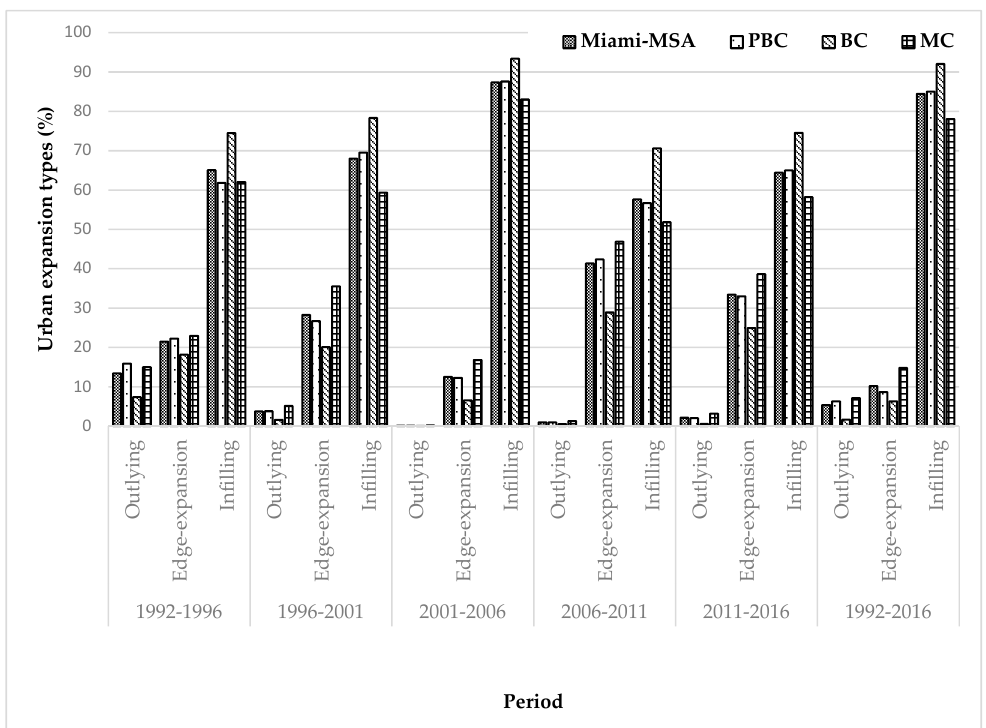
Figure 4. Proportion of Urban Expansion Types in the Study Area over the last 25 Years.